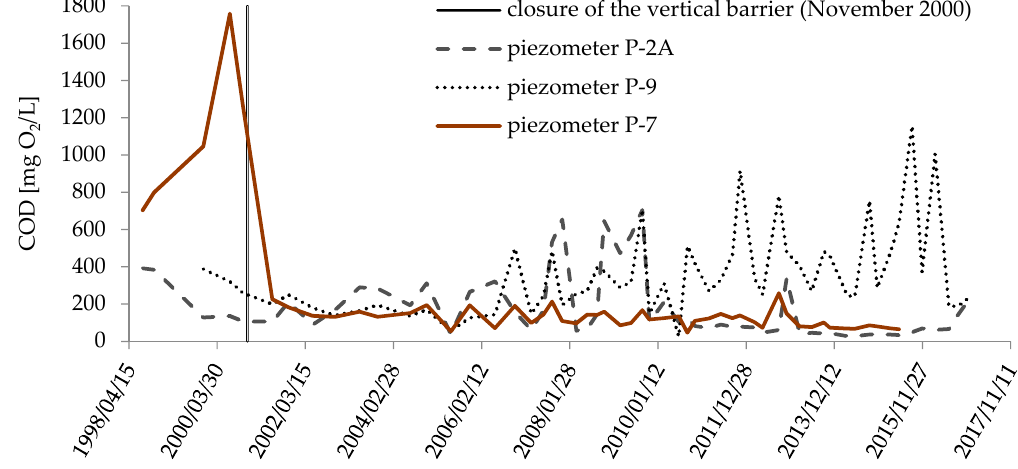
Figure 8. Temporal changes of the COD level in piezometers located in the landfill area.